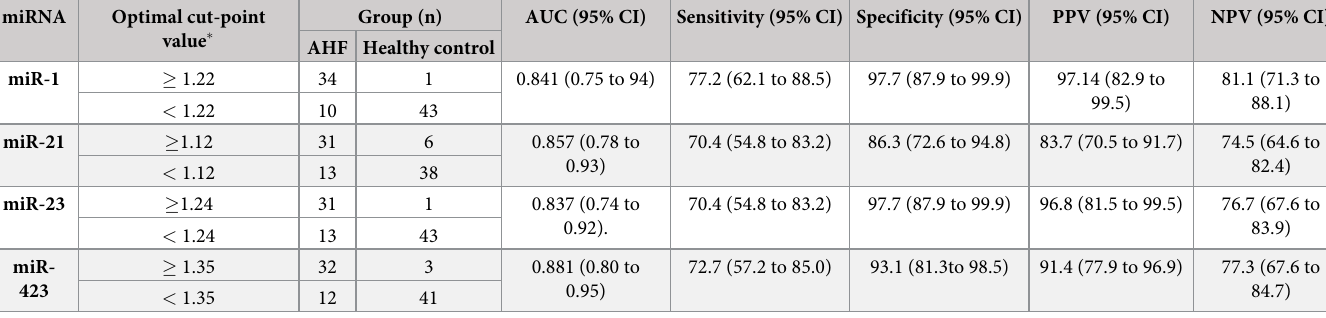
Table 2. Overview of the diagnostic power of selected miRNAs for acute heart failure. miRNA Optimal cut-point value